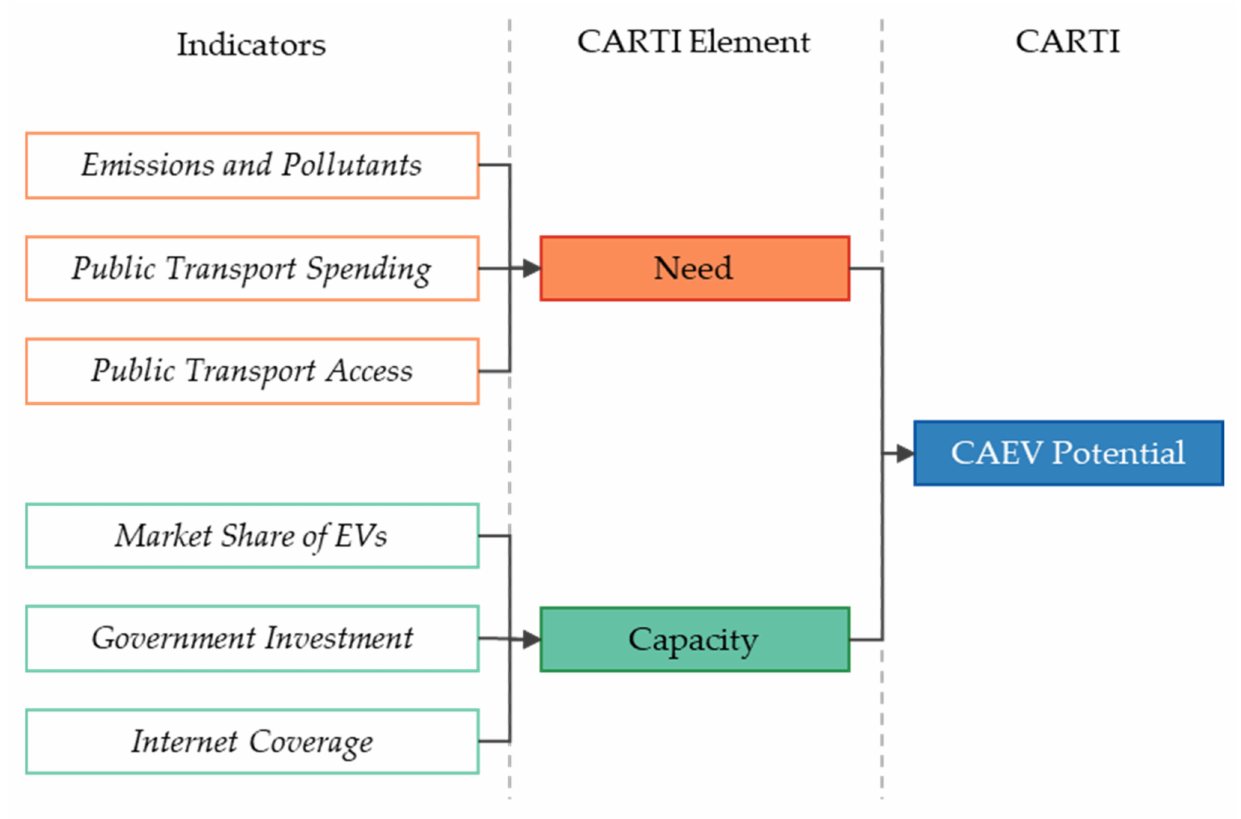
Figure 1. CARTI scoring